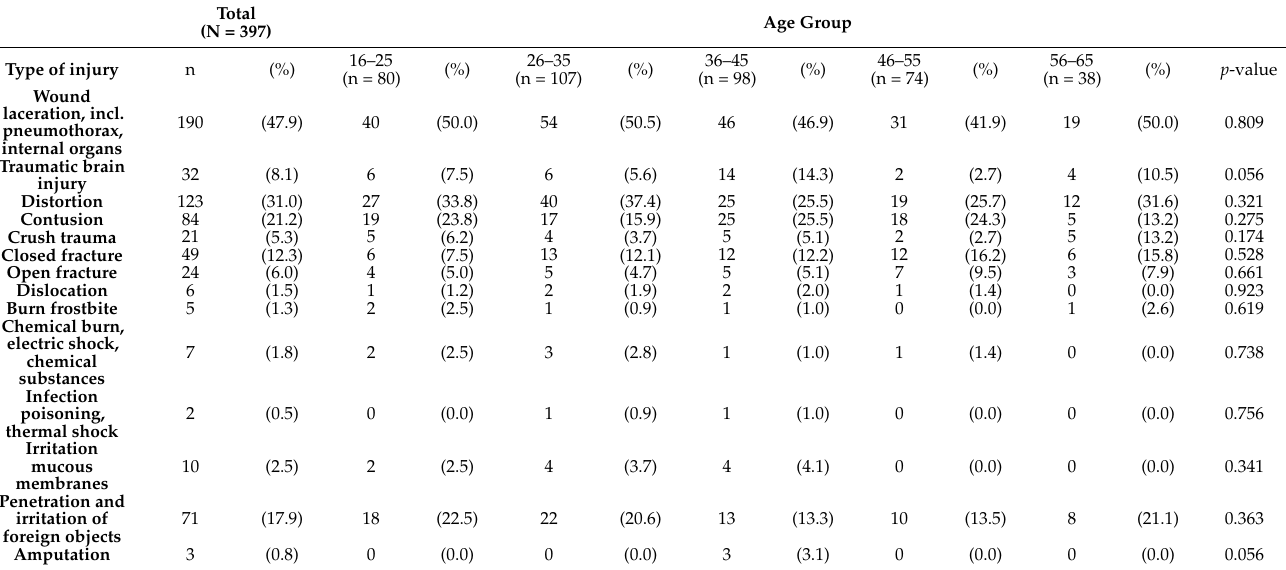
Table 2. Distribution of type of injury among construction workers in Switzerland according to age